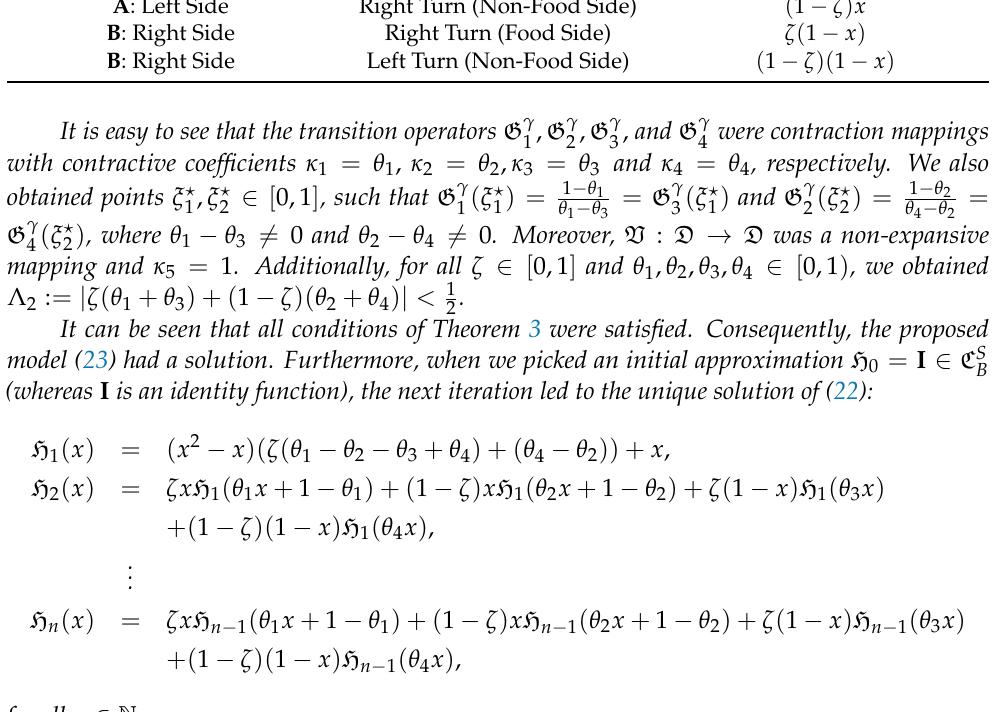
Table 1. The four events with the corresponding probability of occurrence. Placement of Food Side Chosen by Rat Probability of Occurrence A : Left Side Left Turn (Food